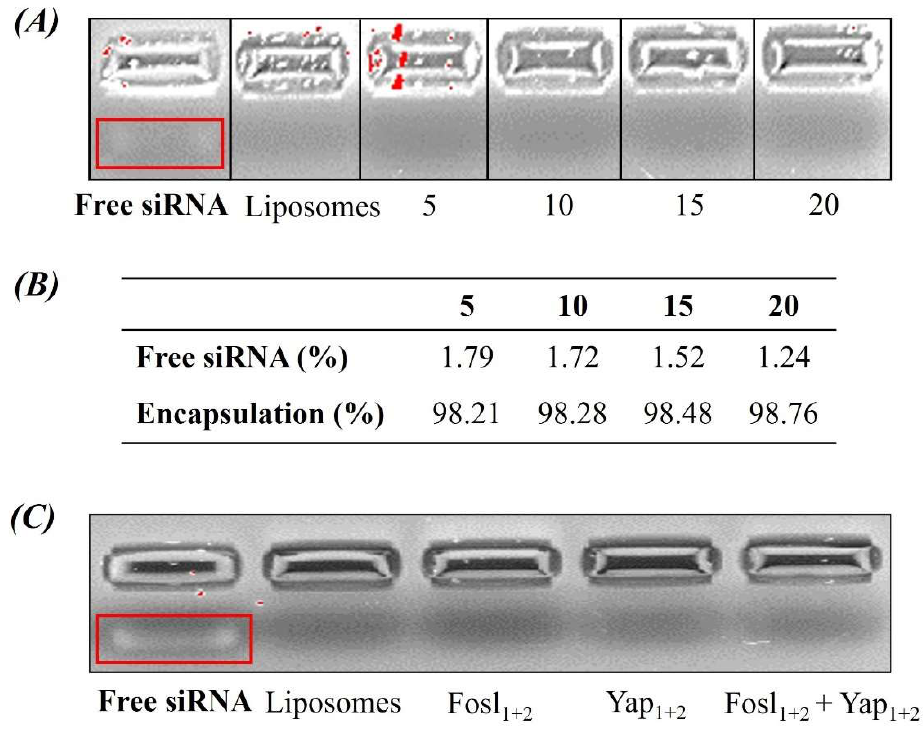
Figure 2. Determination of siRNA encapsulation. ( A ) Electrophoresis in agarose gel of lipoplexes formed using different charges ratios ± (5, 10, 15 and 20). ( B ) Quantification of non-encapsulated siRNA by using a fluorescence RNA label and encapsulation efficiency of the lipoplexes at different charge ratios ( ± ). ( C ) Electrophoresis in agarose gel of lipoplexes using siRNA at charge ratio ± 15. Free siRNA and liposomes at 0.88 μM and 1.67 mM, respectively (the equivalent concentration in the lipoplexes), were used as controls.